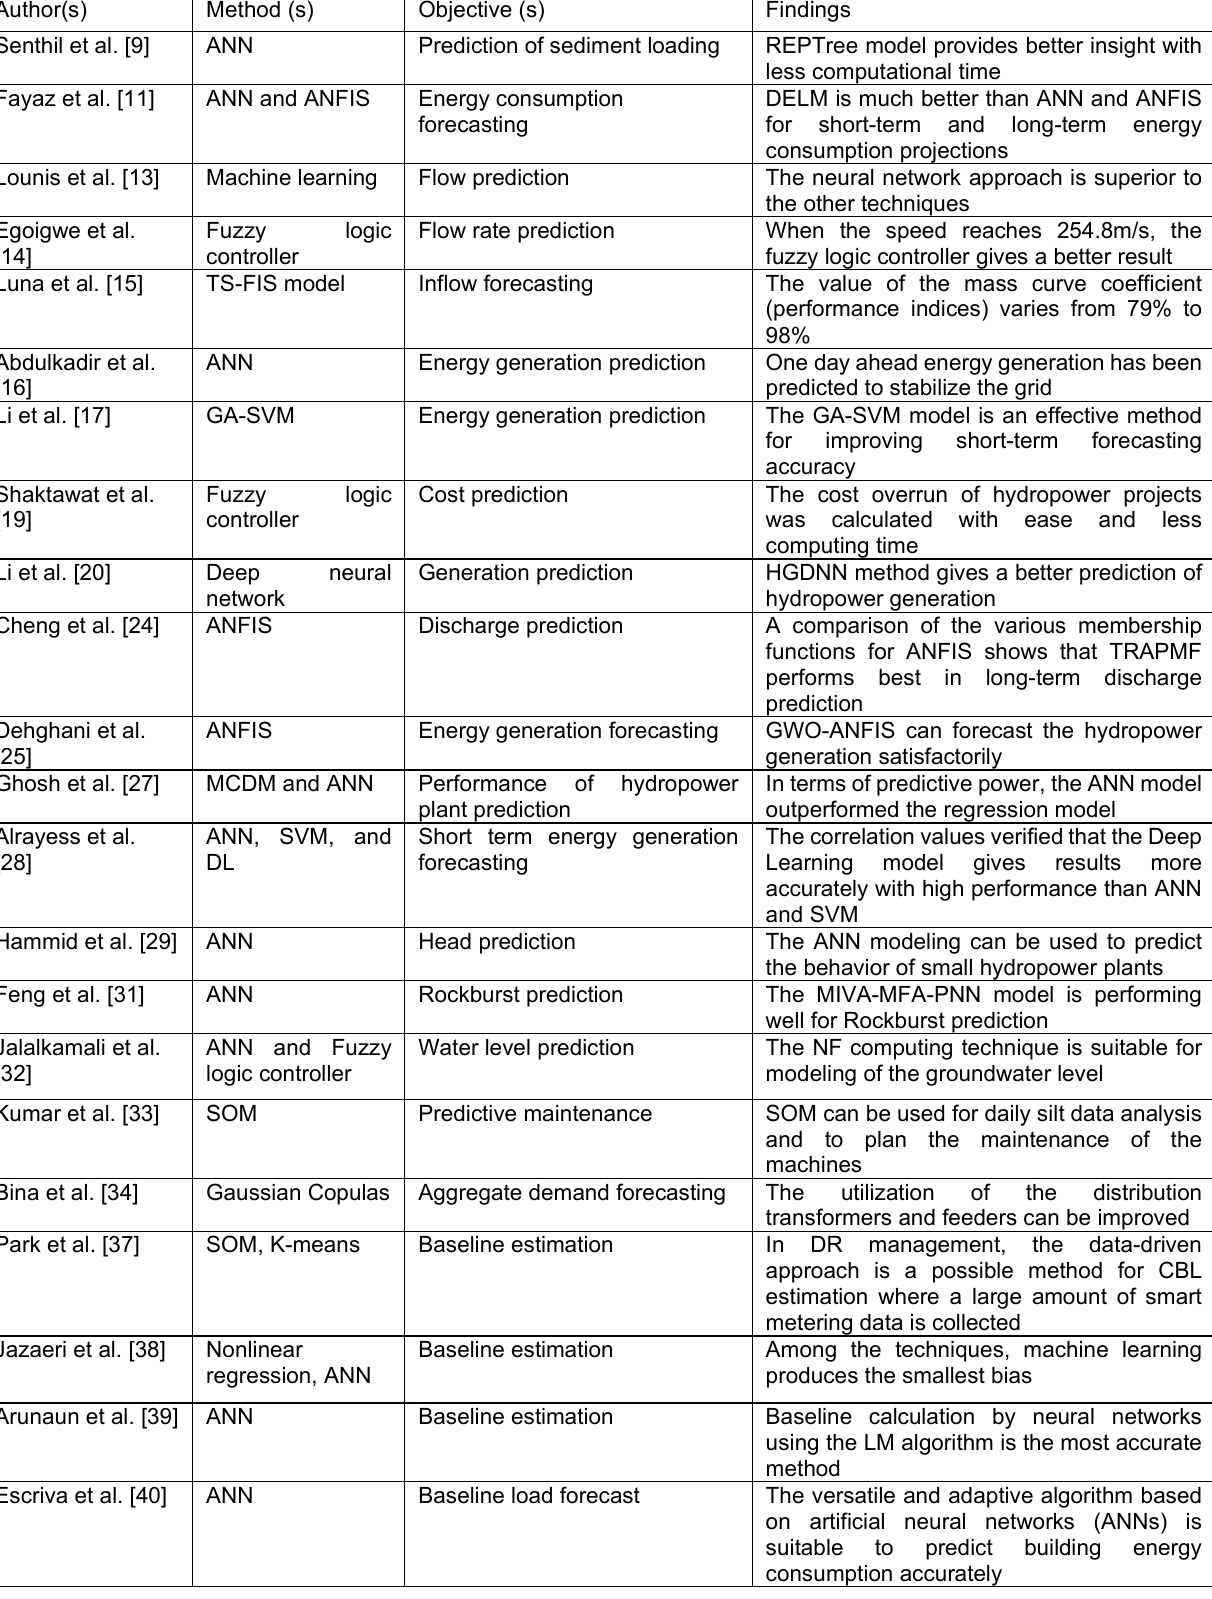
Table 3. Summary of the applications of AI for the forecasting of hydropower